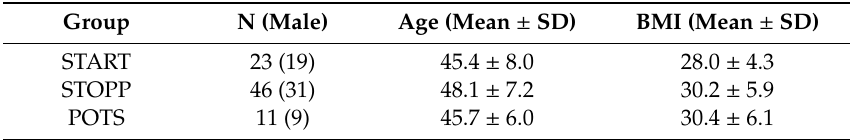
Table 2. The Gulf War Illness (GWI) population exhibited similar age, body mass index (BMI), and gender distributions.